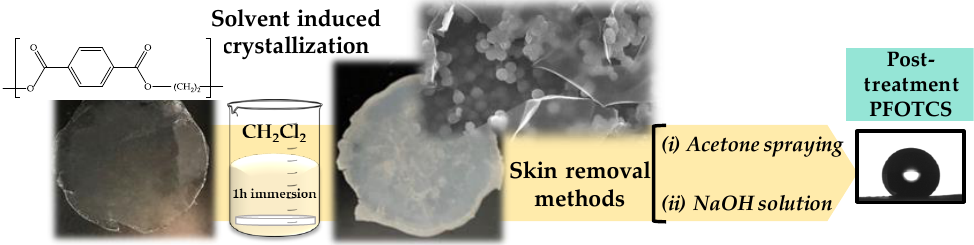
Figure 1. Methodologic scheme followed in this work to prepare the hydrophobic PET surfaces.